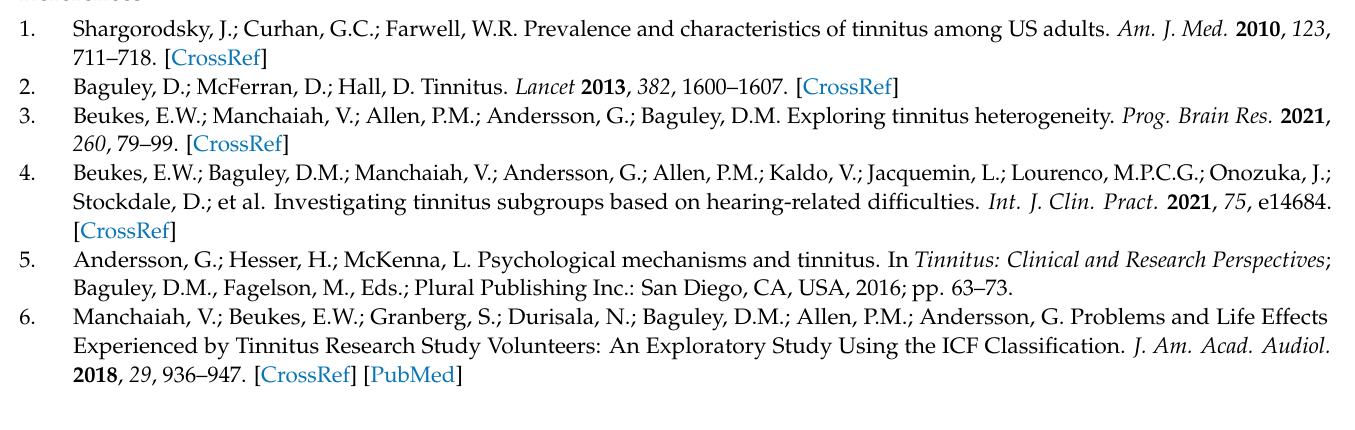
Figshare at http://doi.org/10.6084/m9.figshare.13681924 (accessed on 15 December 2022). Conflicts of Interest: The authors declare no conflict of